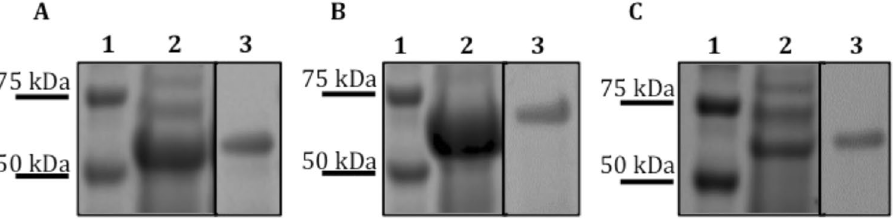
Figure 2. SDS-PAGE analysis of purified recombinant vaccine antigens. Lane 1, Molecular Wight Marker; Lane 2, Clarified whole cell lysate of E. coli expressing strain; Lane 3, IMAC purified, refolded soluble MmpL polypeptide. ( A ) SERoM1, expected size 58 kDa. ( B ) SERoM8, expected size 61 kDa ( C) SERoM10, Expected size 69 kDa. Images A, B and C are cropped from originals (Supplementary Figures 2 and 3) for clarity and